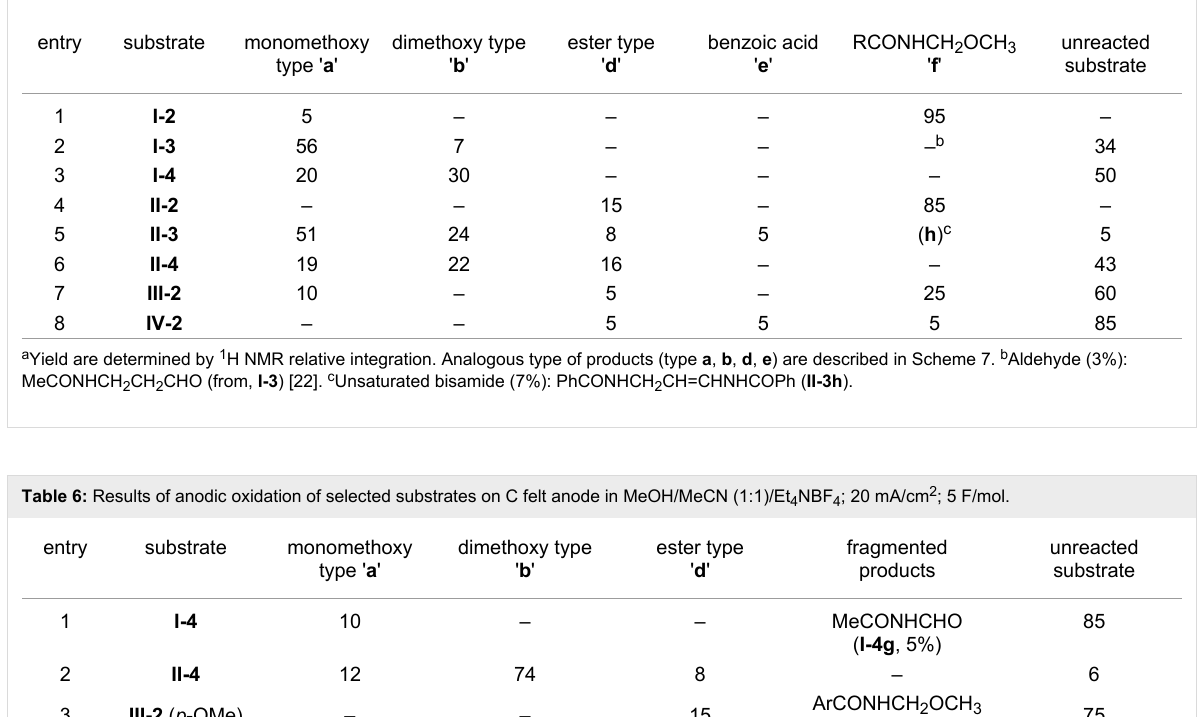
Table 5: Results a of anodic oxidation of bisamides on a C felt anode in MeOH/MeCN (1:1)/LiClO 4 ; 20 mA/cm 2 ; 5 F/mol).